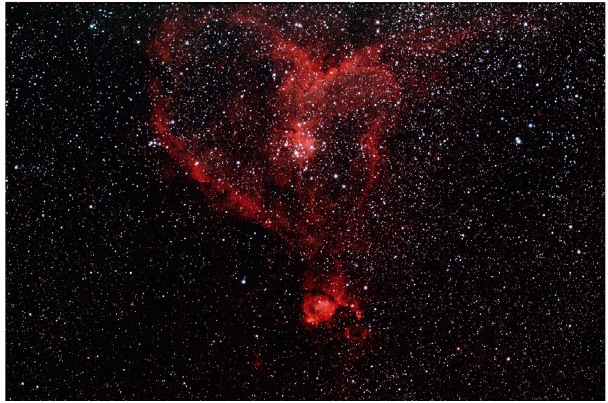
FIG. 2. A CCD image of the “ Heart Nebula, ” IC 1805, taken by a telescope. It is important to be aware that this is only a representation of the real object. Image credit: Jonas